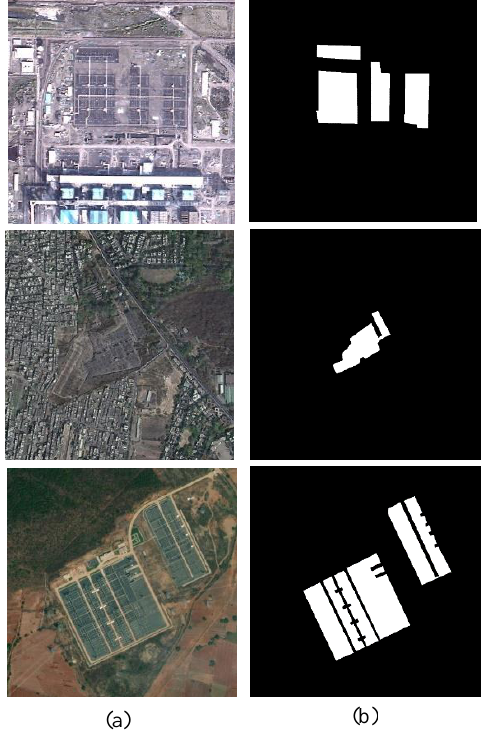
Figure 1 . Illustrate a) image and b) ground truth